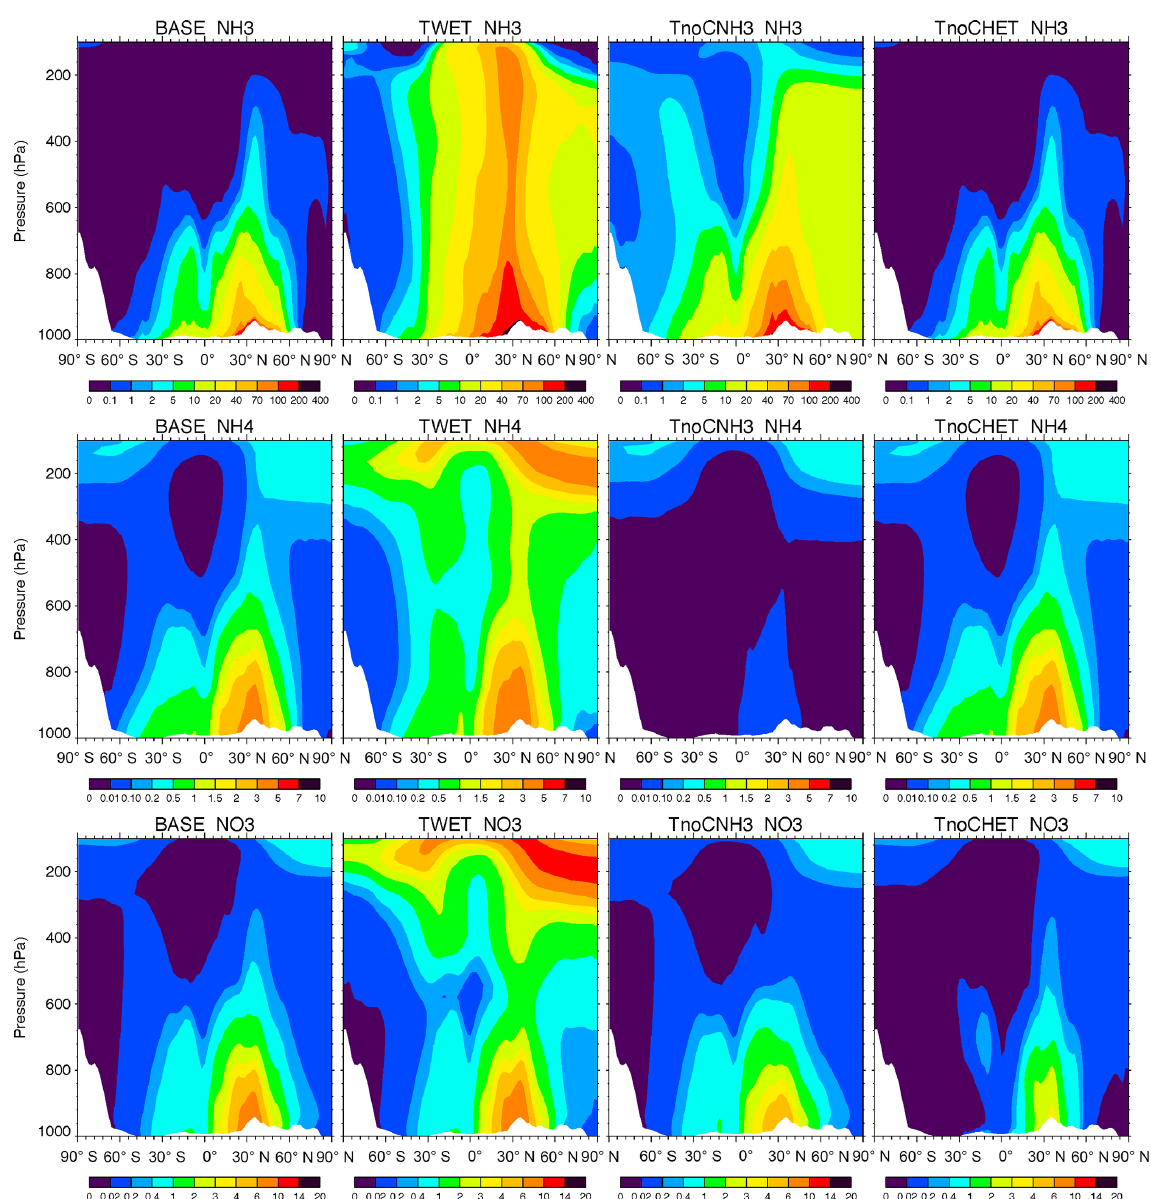
Figure 8. Zonal mean vertical distribution of NH 3 (0.01ppb), NH + and three sensitivity experiments explained in Table